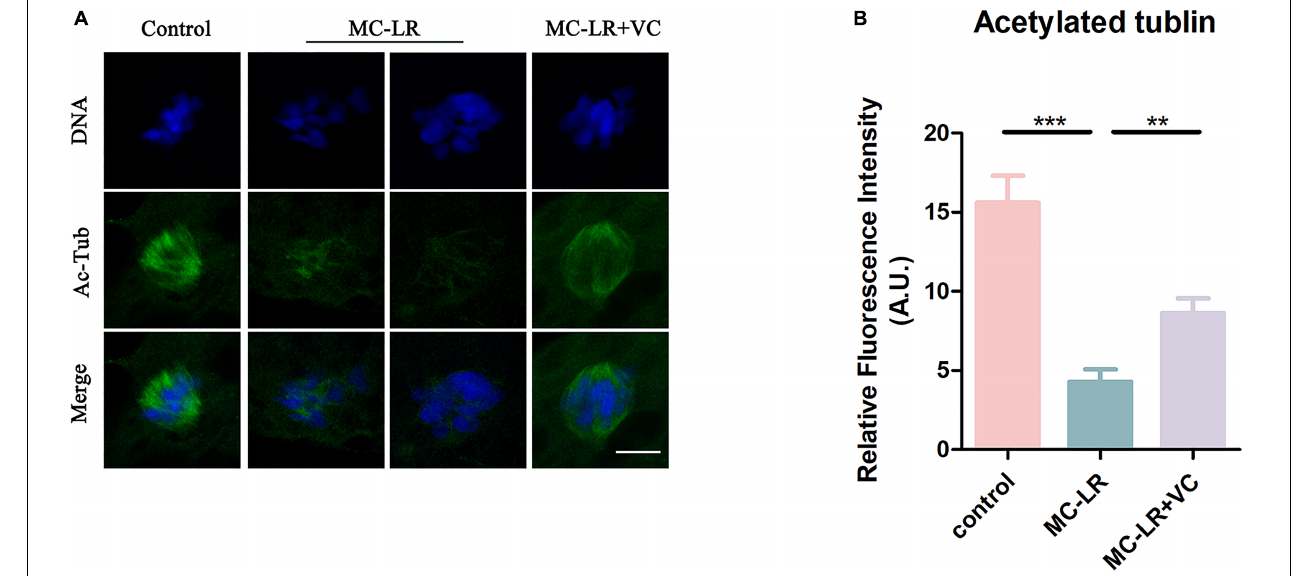
FIGURE 3 | VC increases the level of acetylation of α -tubulin in MC-LR-exposed oocytes. (A) Representative images of α -tubulin in the control, MC-LR-exposed, and VC-rescued groups. Bar = 5 µ m. (B) Quantitative analysis of the fluorescence intensity of acetylated α -tubulin in the control, MC-LR-exposed, and VC-rescued groups. ** p < 0.01, *** p <